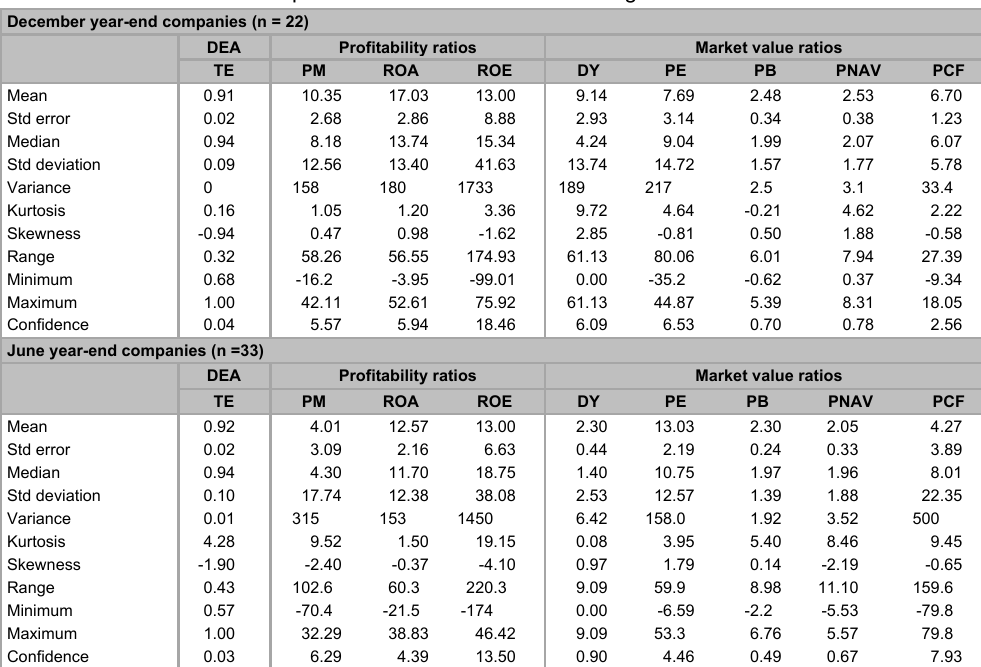
Descriptive statistics of variables: Average